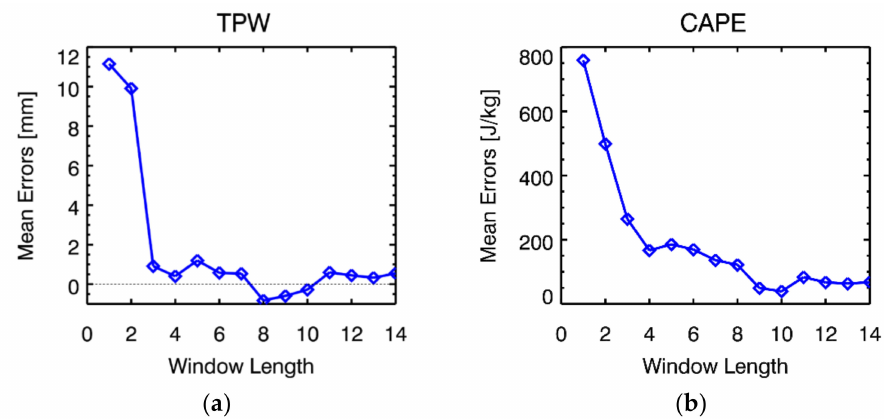
Figure 6. Mean errors from test results depending on the window length in ( a ) TPW and ( b ) CAPE.